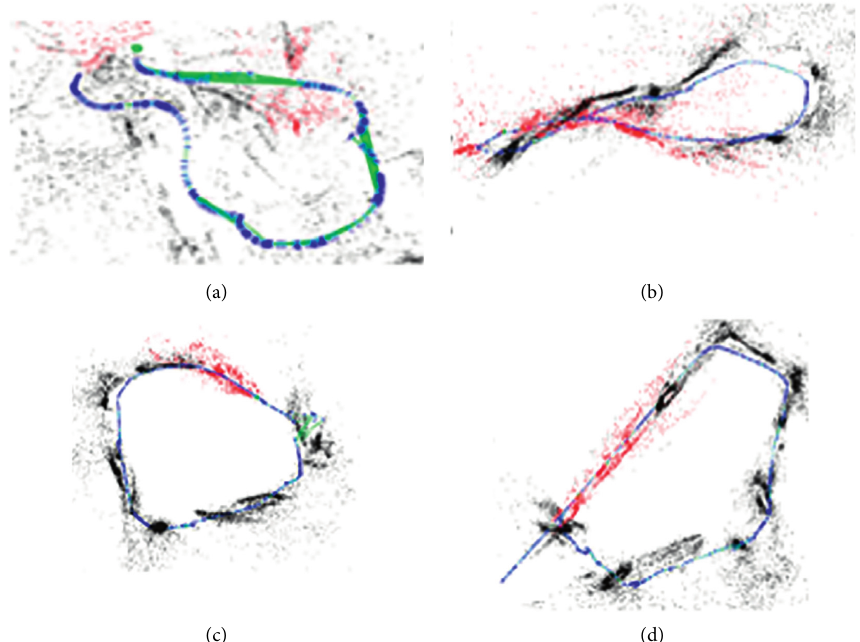
Figure 7: Pose recovery and point cloud recovery results of four loop detection algorithms: (a) recovery 1, (b) recovery 2, (c) recovery 3, and (d) recovery